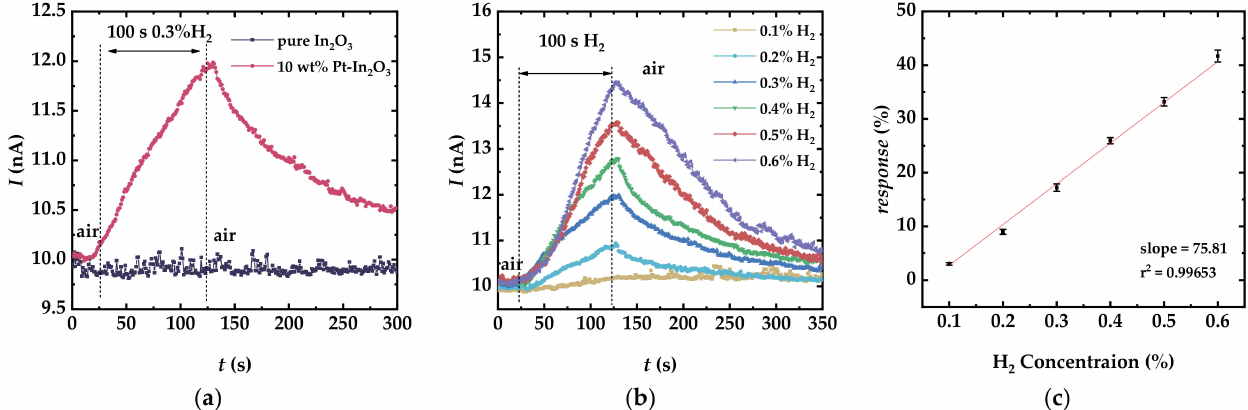
Figure 2. Results from dry H 2 sensing tests performed with the Pt-In 2 O 3 resistive sensor exposed to H 2 . ( a ) Comparison between the resistive sensors with pure In 2 O 3 and 10 wt.% Pt-In 2 O 3 for the detection of 0.3% H 2 . ( b ) Dynamic response of the sensor towards different concentrations of H 2 in a range of 0.1–0.6% at room temperature. A determined concentration of dry H 2 gas was introduced in the period of 20–120 s. ( c ) Sensor response as a function of H 2 concentration. Each error bar corresponds to one standard deviation considering the uncertainty of three response